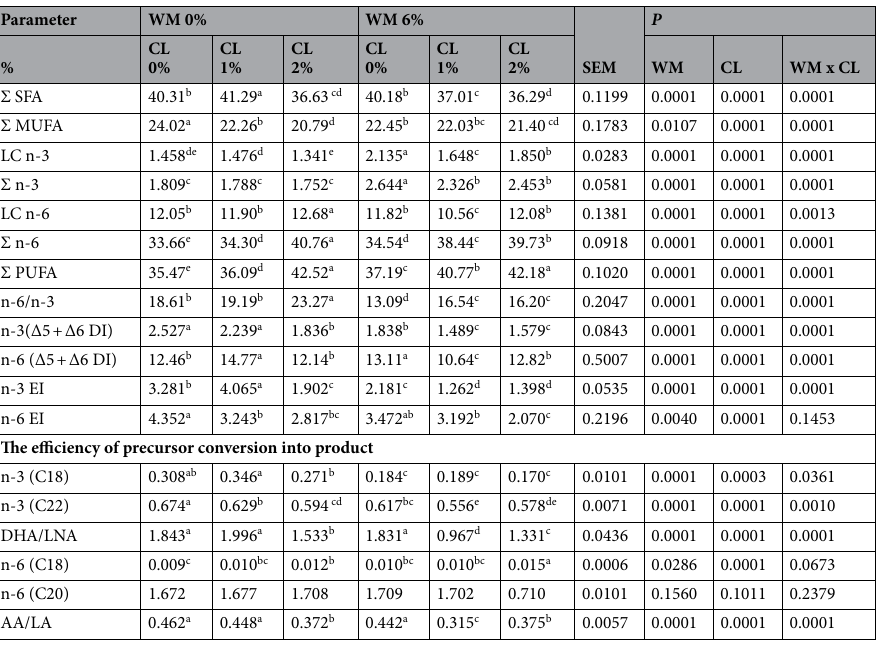
Table 4. Effect of WM and CL on lipid quality indices based on fatty acids profile of liver. Means within a row with no common superscript differ ( p < 0.05). SFA Saturated fatty acids, MUFA Monounsaturated fatty acids, PUFA polyunsaturated fatty acids, LC n-3 Long chain n-3 fatty acids, LC n-6 Long chain n-6 fatty acids; n3(Δ5 + Δ6 DI) or n6(Δ5 + Δ6 DI) Desaturase index Δ5 + Δ6 for n-3 or n-6 fatty acids , n3 EI or n6 EI elongase index for n-3 or n-6 fatty acids, LNA (C18:3n-3); EPA (C20:5n-3); DHA (C22:6n-3); LA (C18:2n-6); AA